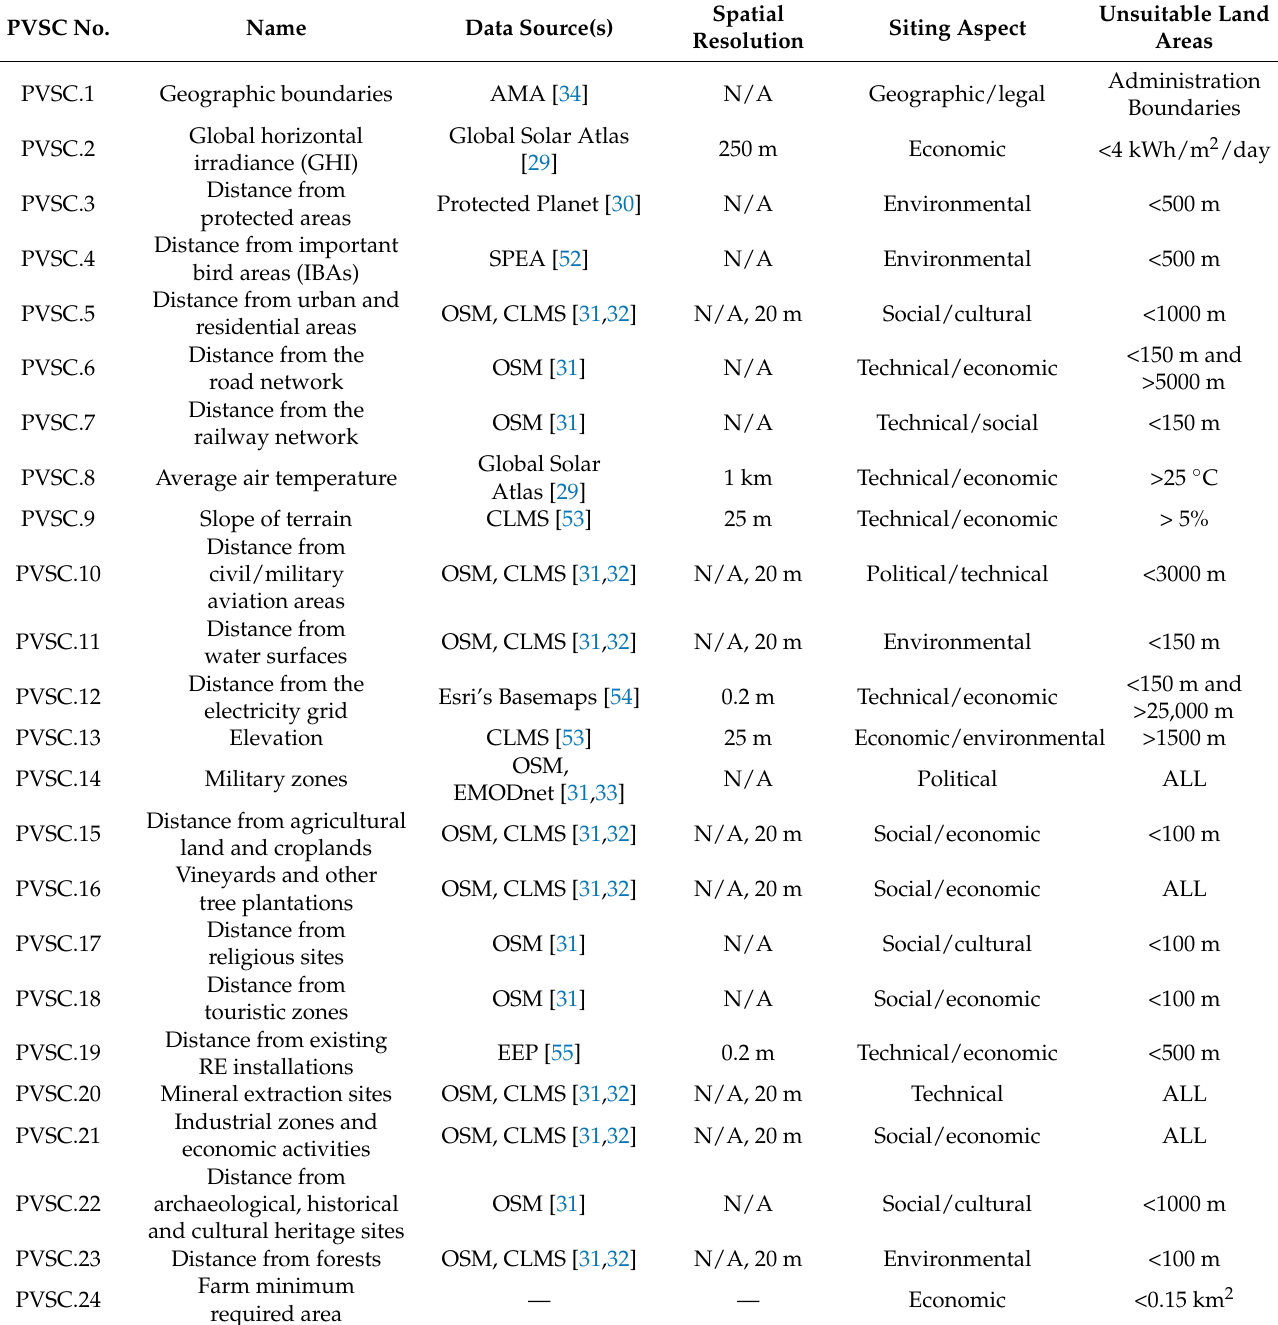
Table 3. PVSC and their incompatibility zones applied in Phase 3 of the proposed framework. Note